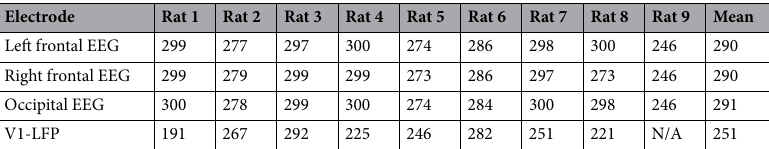
Table 2. Number of trials (out of 300) used to calculate the average VEPs for all the electrodes after the artifact rejection